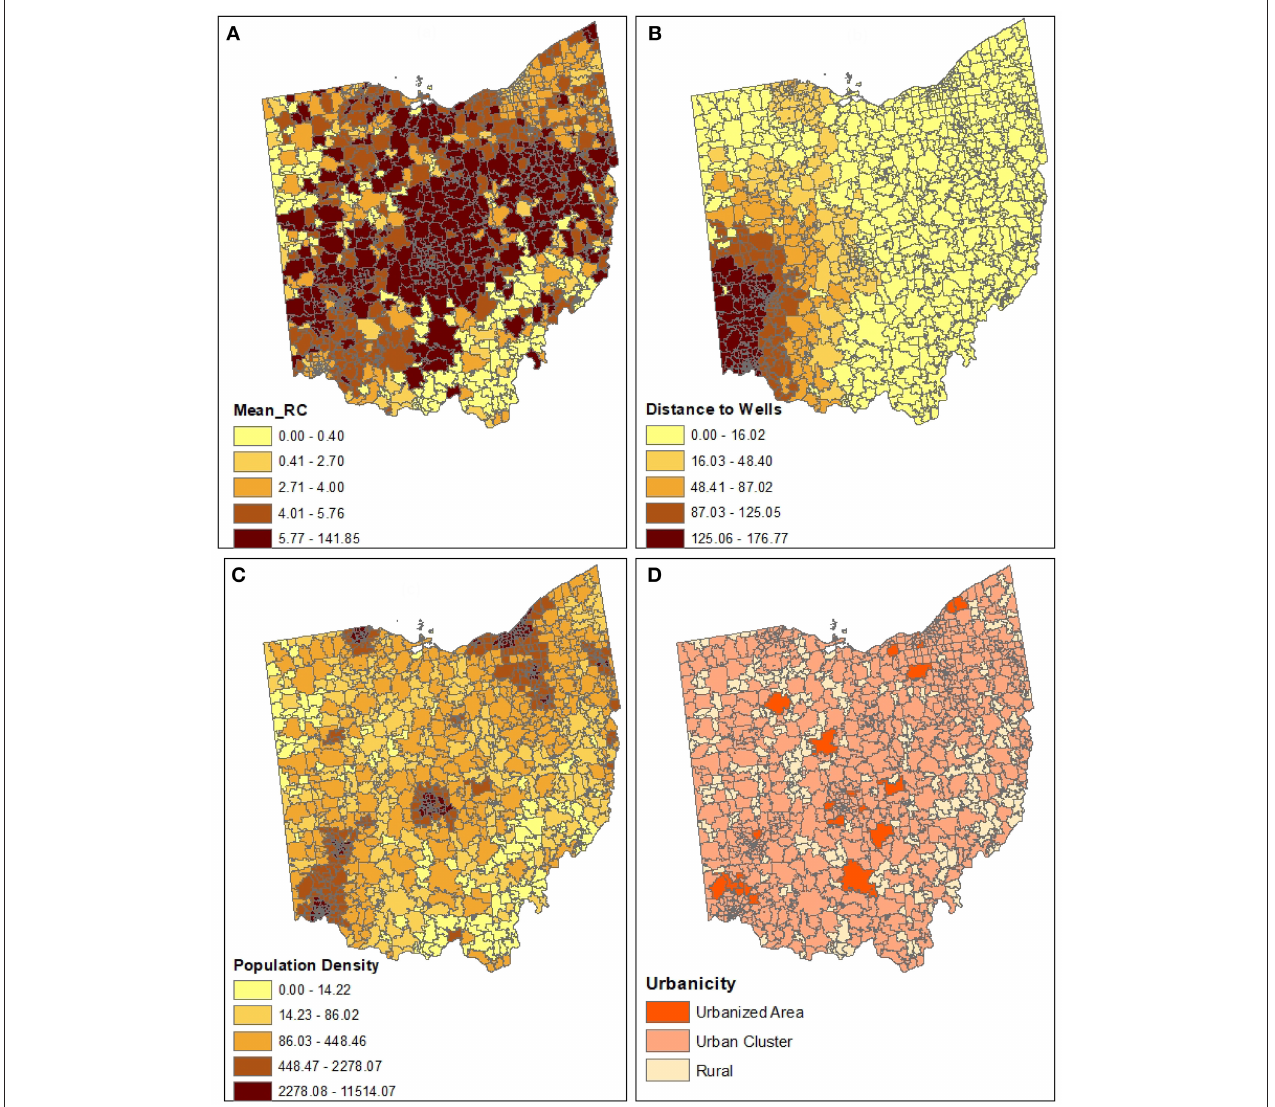
FIGURE 3 | Distribution patterns of variables at zip code level: (A) Radon Concentration (pCi/l); (B) Euclidean Distance to Shale Wells (km); (C) Population Density (number of people per square mile); (D)